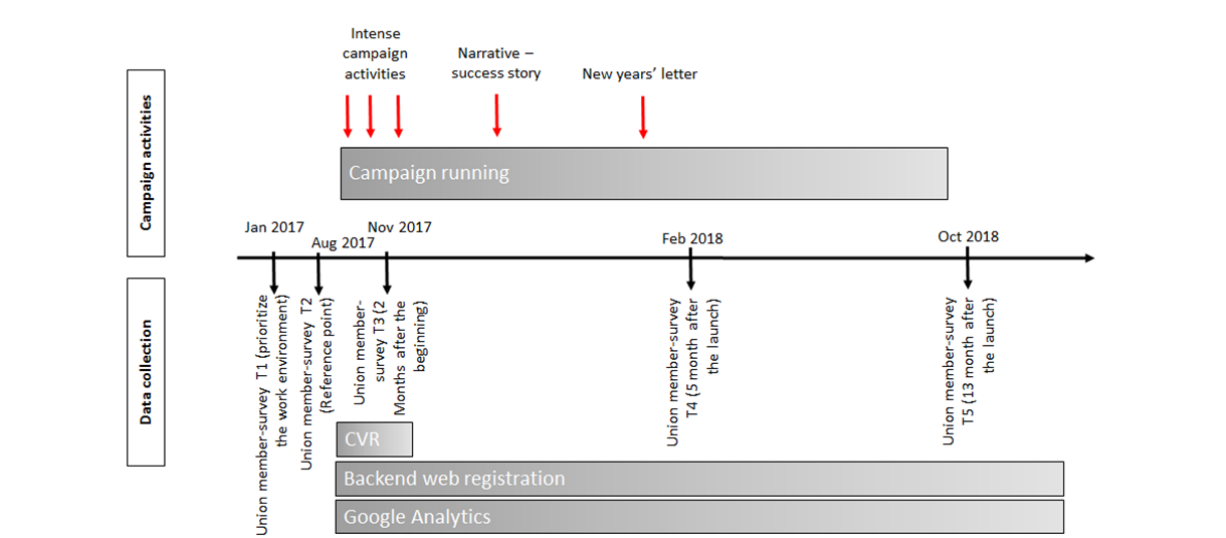
Figure 4. Overview of campaign activities and data